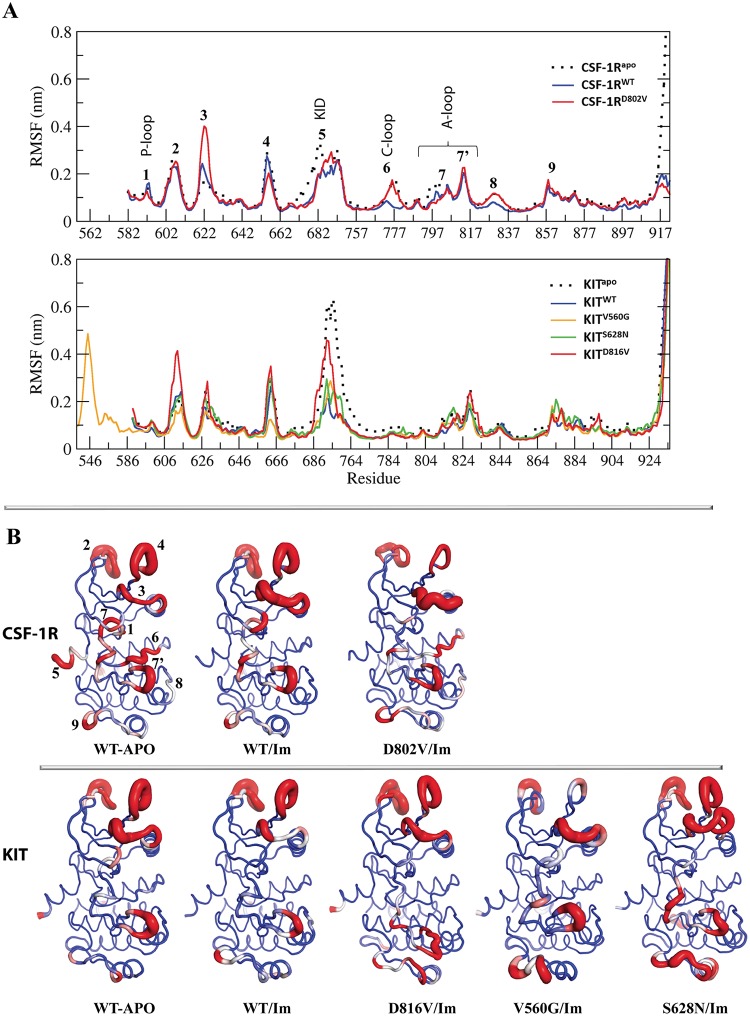
MD simulations of the RTK-Imatinib complexes.(A) The Root Mean Square Fluctuations (RMSFs) computed on the backbone atoms averaged over the total production simulation time of CSF-1RWT and CSF-1RD802V (blue and red, respectively) (top panel) and of KITWT, KITD816V, KITV560G and KITS628N (blue, red, yellow and green, respectively) complexes (bottom panel) were compared to those in the non-bound receptors (dotted black lines). (B) The average conformations of CSF-1R (top panel) and KIT (bottom panel) are presented as tubes. The tube size is proportional to the residue atomic fluctuations computed on the backbone atoms. The highly fluctuating regions are colored in red and numerated for CSF-1R in (A) and (B).